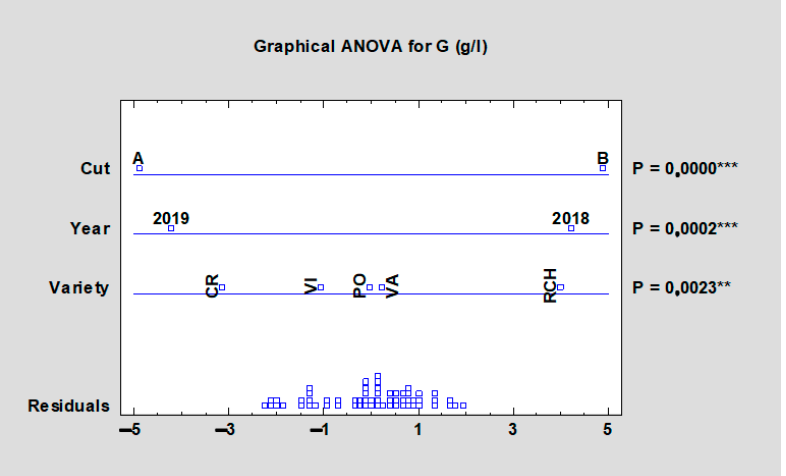
Figure 5. Effect of the experimental year, cultivar, and term of the harvest on the mean glucose content of all rhubarb cultivars. Abbreviations: PON, ´Poncho´; CRE, ´Canadian Red´; VAL, ´Valentine´; RCH, ´Red Champagne´; VIC, ´Victoria´. LSD test with significance: p ≤ 0.01 (**), or p ≤ 0.001 (***).